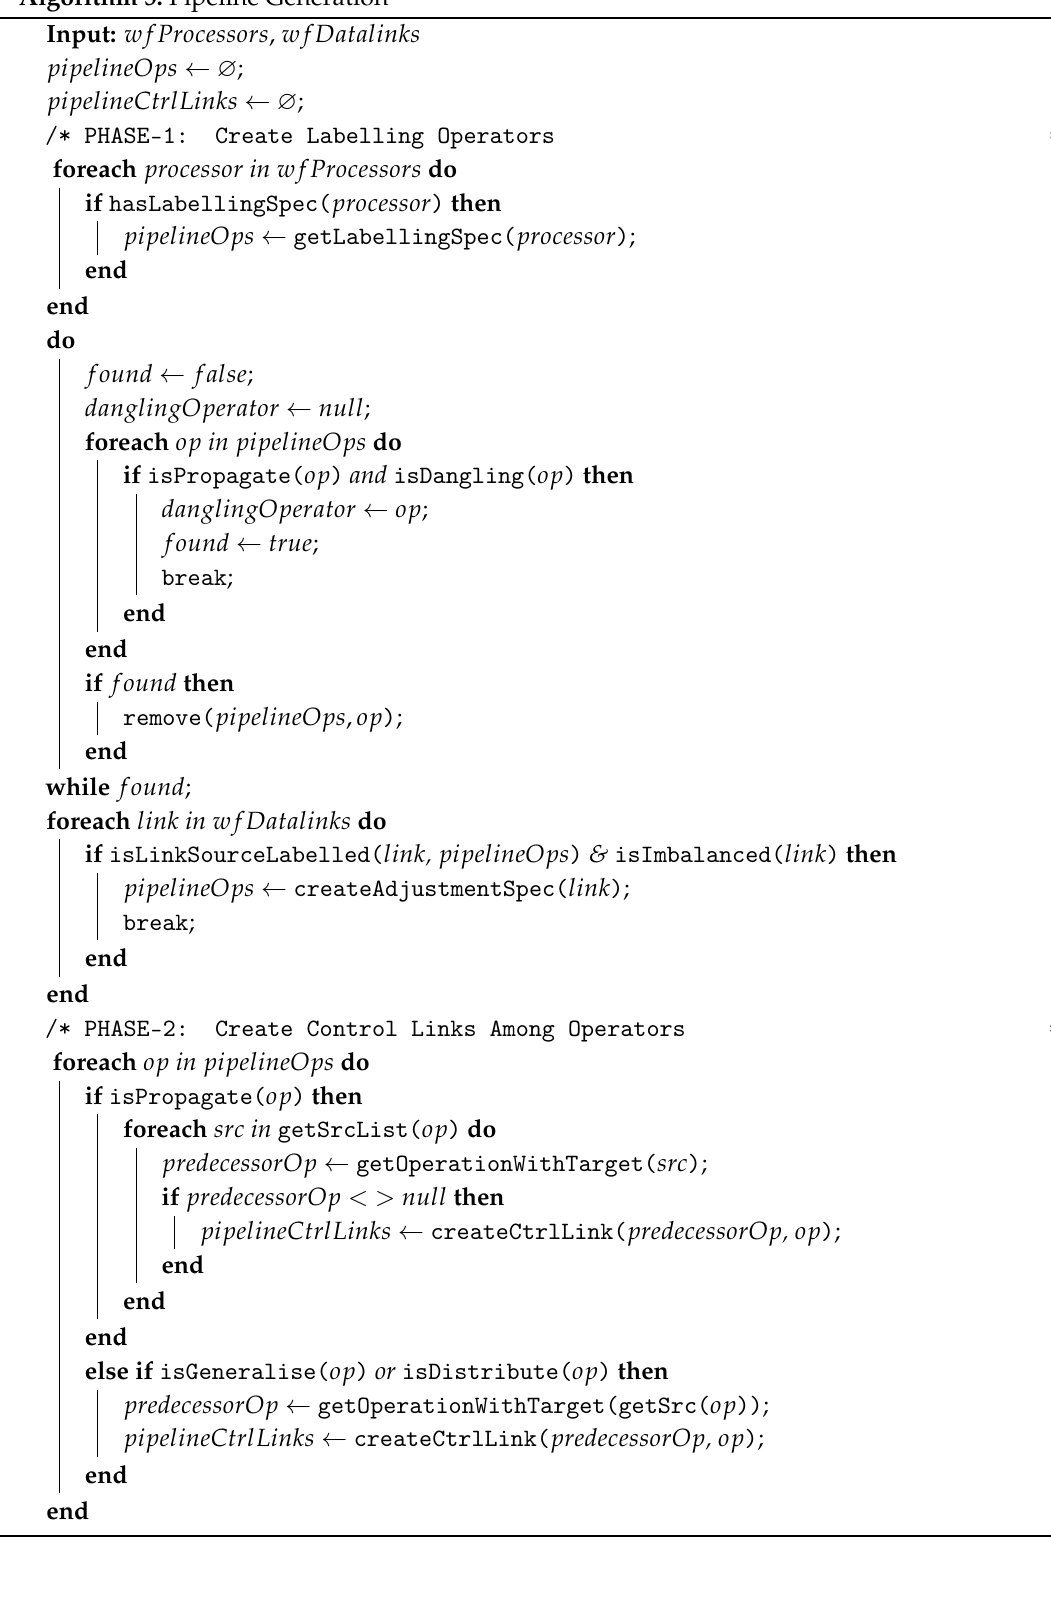
Algorithm 5: Pipeline